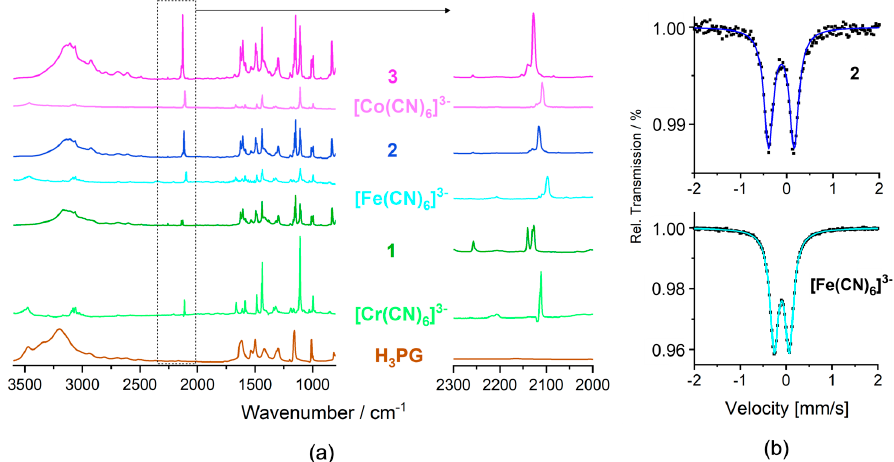
Figure 6. ( a ) Infrared spectra of 1 - 3 in the absorption mode compared with the spectra of H 3 PG and (PPh 4 ) 3 [M(CN) 6 ] · n H 2 O precursor salts with enlargement of including the ν (C ≡ N) stretching vibration range shown on the right. ( b ) 57 Fe Mössbauer spectra of 2 ( top ) and of the (PPh 4 ) 3 [Fe(CN) 6 ] · 7H 2 O precursor ( bottom